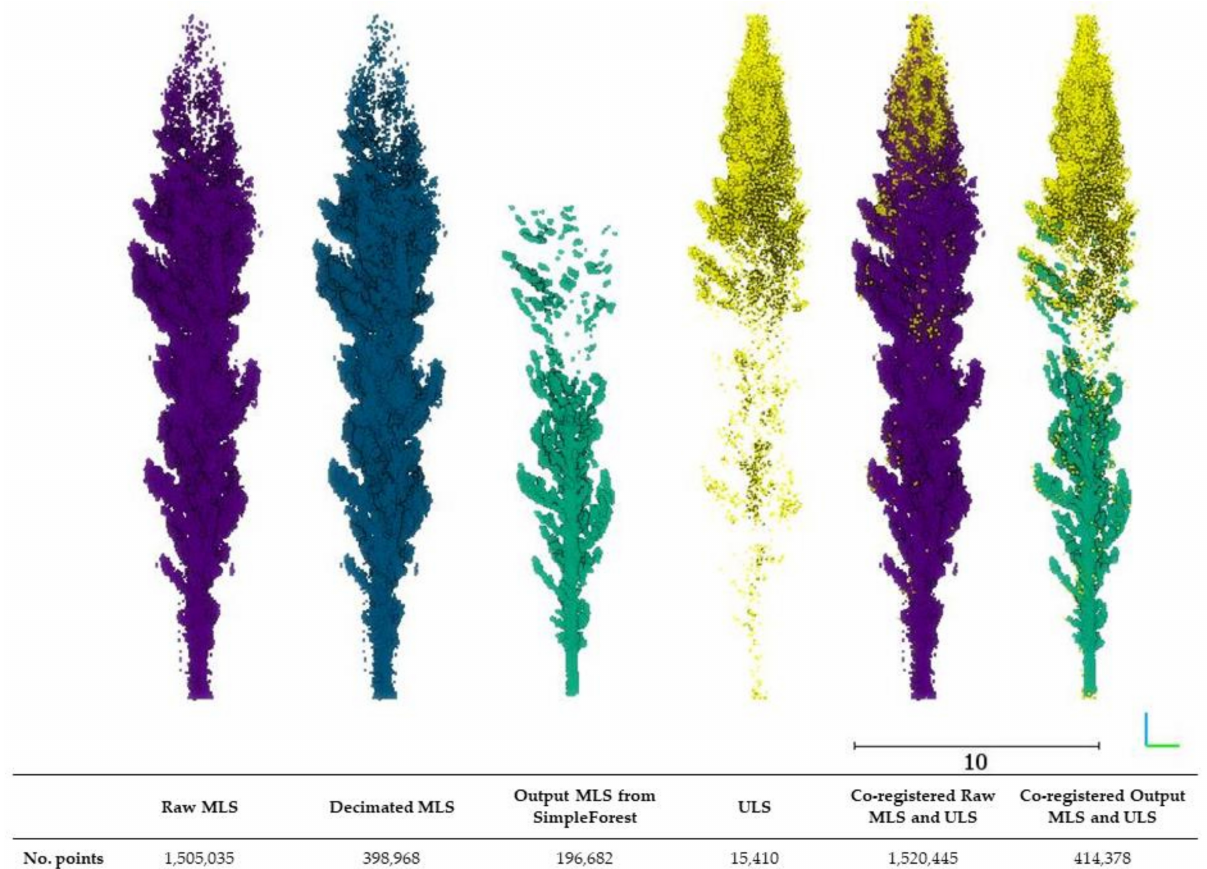
Figure 6. Detailed views of an individual tree point cloud (Tree F43) from the MLS and ULS data. MLS data are shown in their raw, decimated and processed forms. Figure also includes overlaid images of the co-registered raw MLS and ULS point clouds, demonstrating the similarities in maximum height and co-registered processed MLS and ULS point clouds. Number of points is reported below each